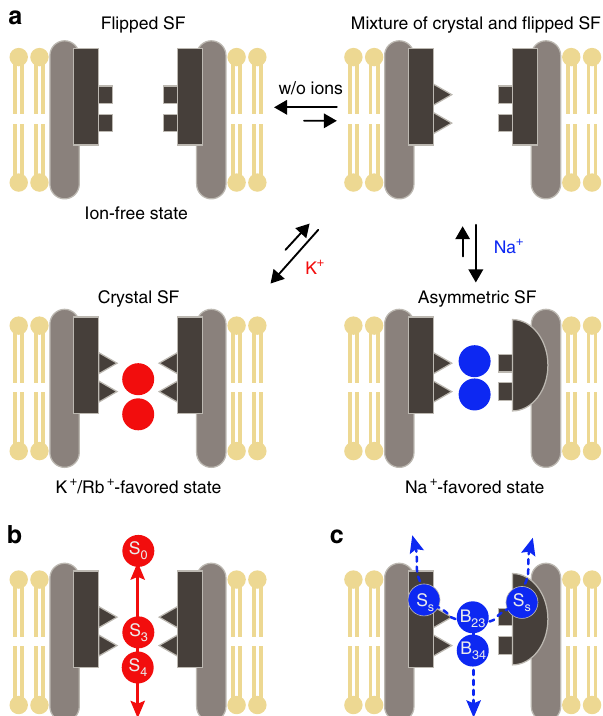
Fig. 6 Schematic model of the non-selective ion-conduction mechanism in NaK. a Equilibrium of NaK conformations without ions or in the presence of Na + or K + . Plasticity in the SF enables Na + binding, further resulting in an asymmetric deformation of the SF. b K + conduction pathway from the MD simulations. c Na + conduction in both directions uses the four side entries (dashed line). The additional binding sites (S side ) at the side entry are labeled as S